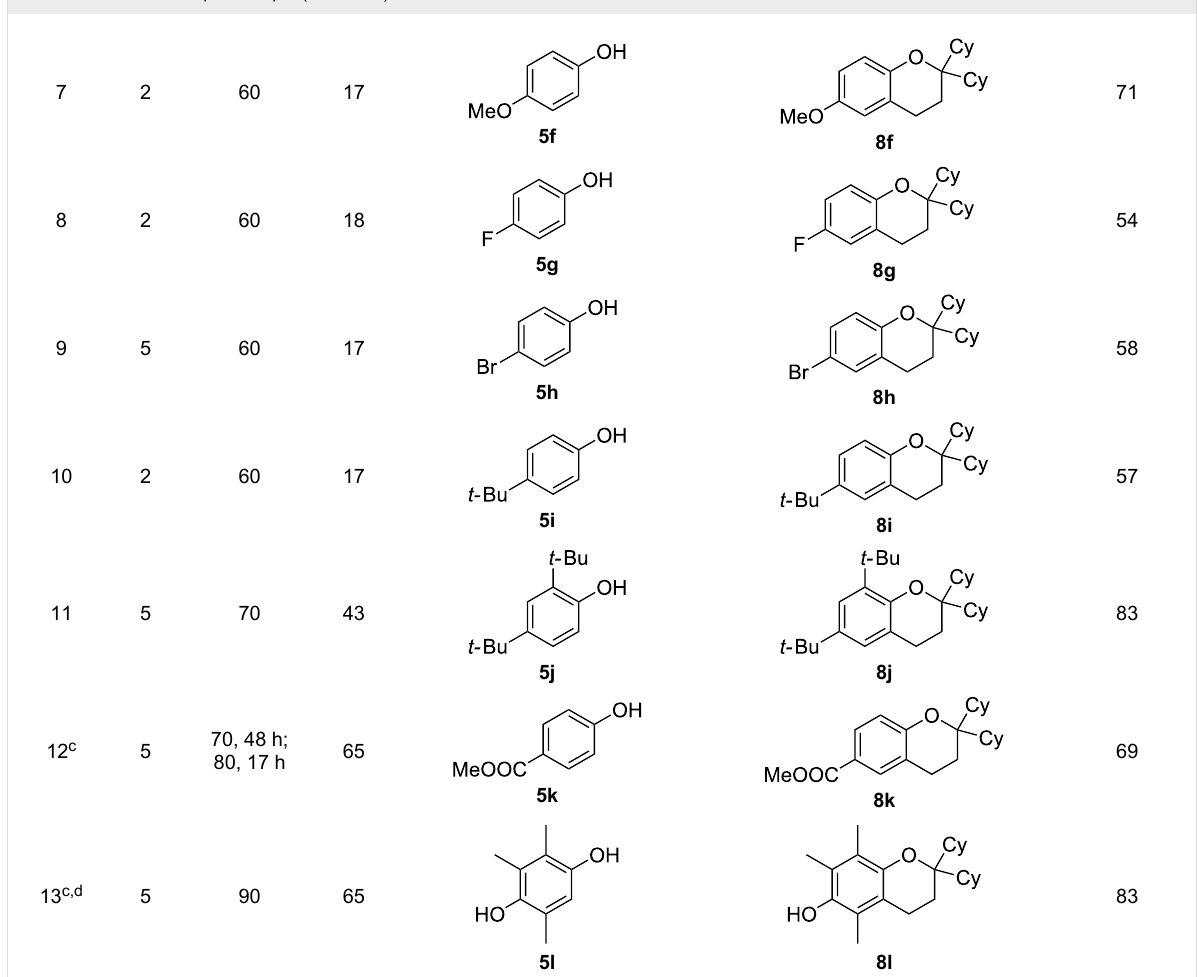
Table 2: Phenol nucleophile scope.